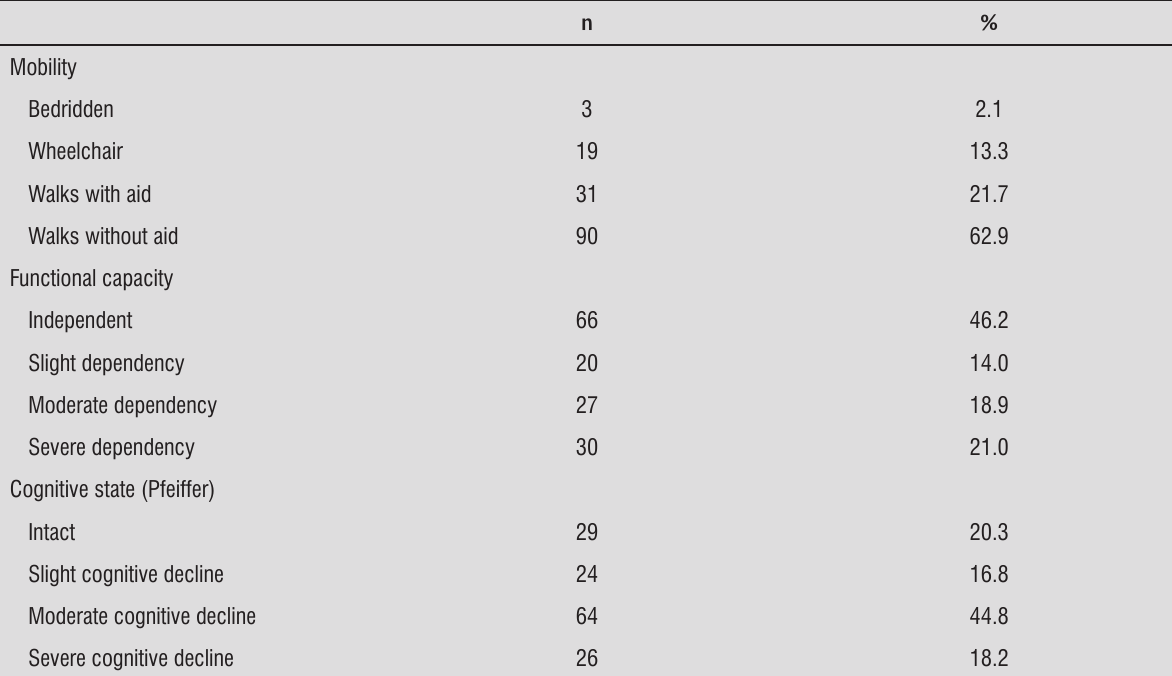
Table 1 - Socio-demographical and health-related information – Natal (RN), 2014